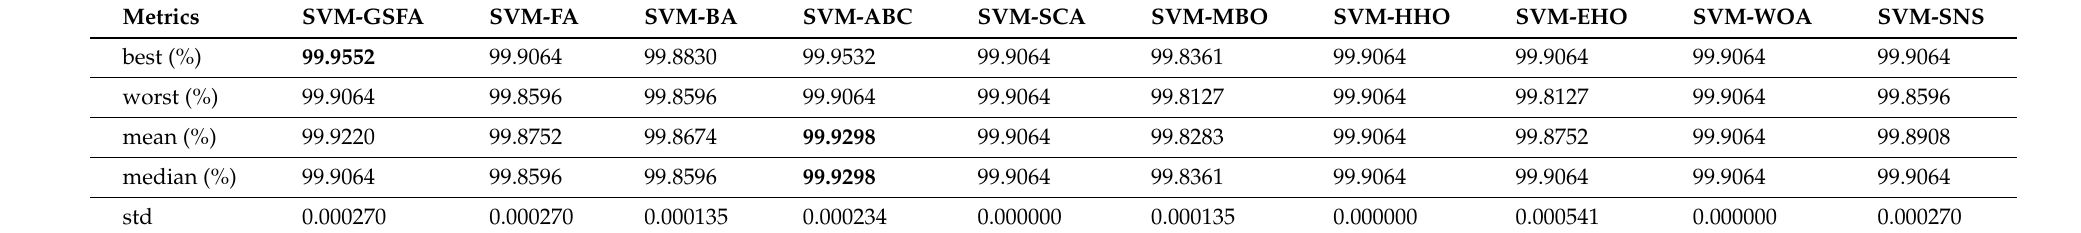
Table 2. SVM Credit Card Fraud small NO SMOTE—general metrics.